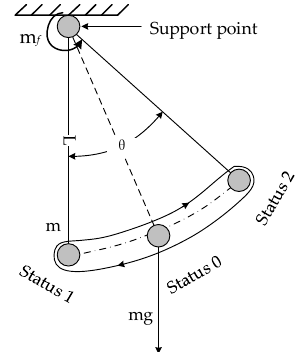
Figure 4. Dynamics diagram of the Semi-strap-down Stabilized Platform ( SSP).